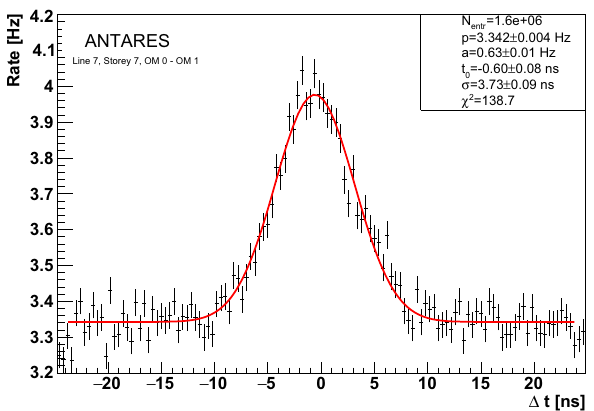
Fig. 2 Example of the detected hit time differences, Δ t , between two adjacent OMs. The fitted parameters are listed as well (see Eq. 5 for details). The plot refers to one pair of OMs in the same storey (Line 7, Storey 7, OM 0 - OM 1) for one of the periods considered in the